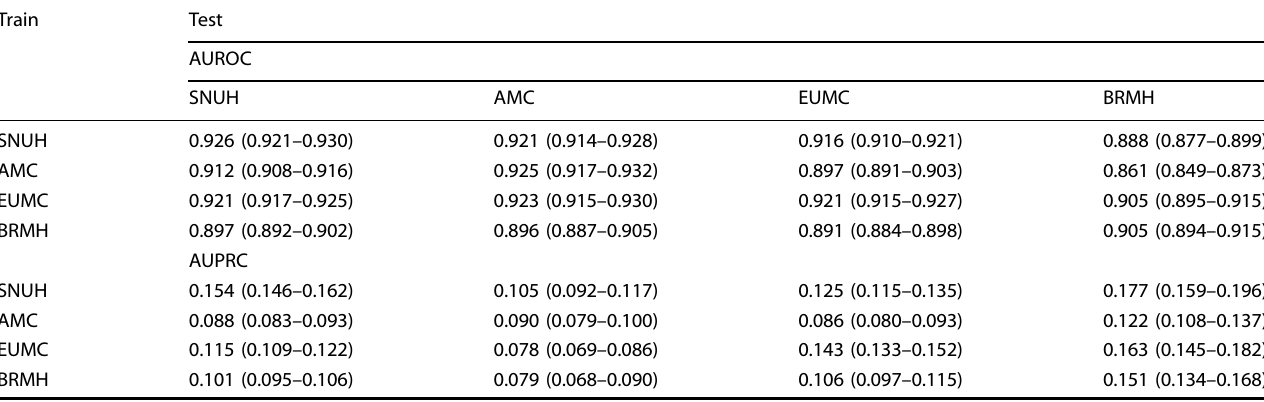
Table 3. Validation results of four lab models using only 12 features of laboratory test for postoperative 30-day mortality.